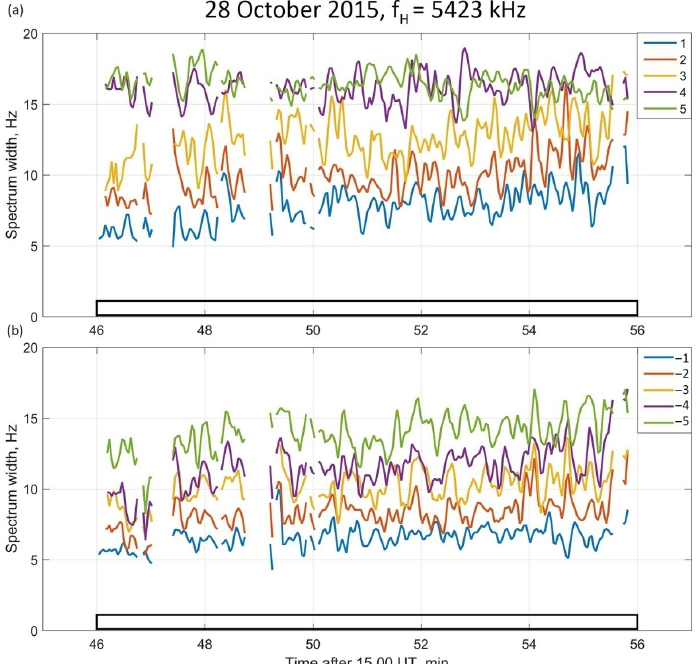
Figure 4. Behavior of spectral width for ( a ) the upshifted from the first to the fifth (labeled as 1, 2, 3, 4, 5 and ( b ) downshifted ion gyro-harmonic structures (labeled as − 1, − 2, − 3, − 4, − 5 and − 0.5) in the course of the pump pulse from 15:46 to 15:56 UT. Gaps in the spectral width of the ion gyro-harmonic structures correspond to the presence of interference. The power of downshifted spectral structures averaged through the pump cycle from 15:46 to 15:56 UT, and the delay in the time of occurrence of the spectral structures depending on the harmonic number is shown in Figure 5. With the rise of the harmonic number, the intensities of the discrete spectral components dropped and their delay in the time of occurrence, relative to the pump onset, increased. These features and behavior of the discrete spectral components indicate the presence of a cascade process in their excitation.